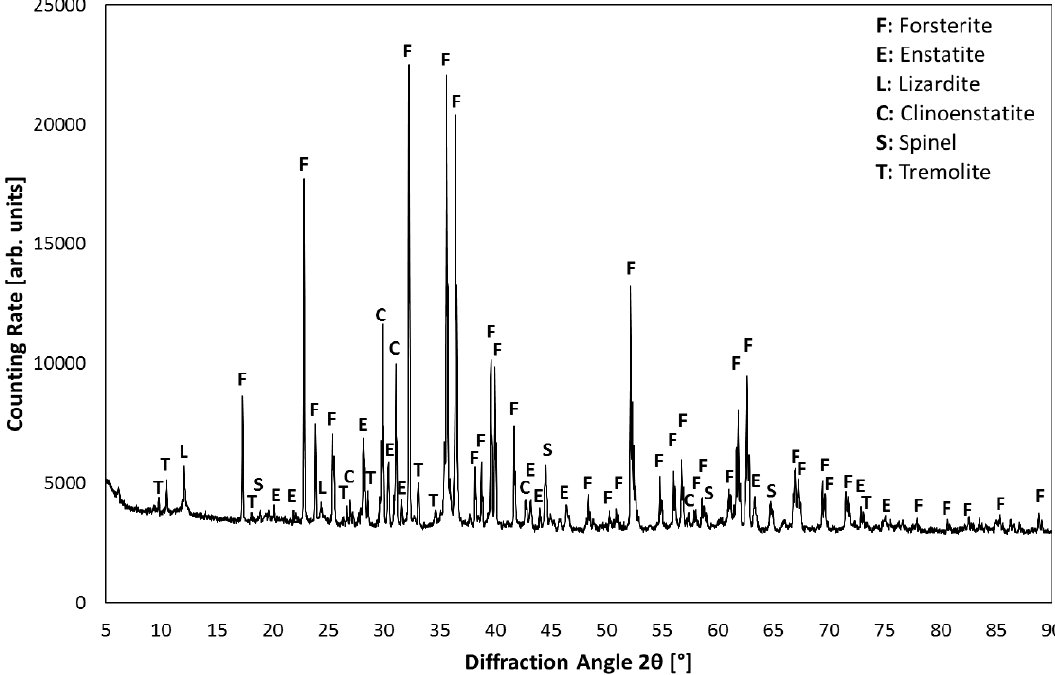
Figure 7. XRD analysis of initial olivine sample.